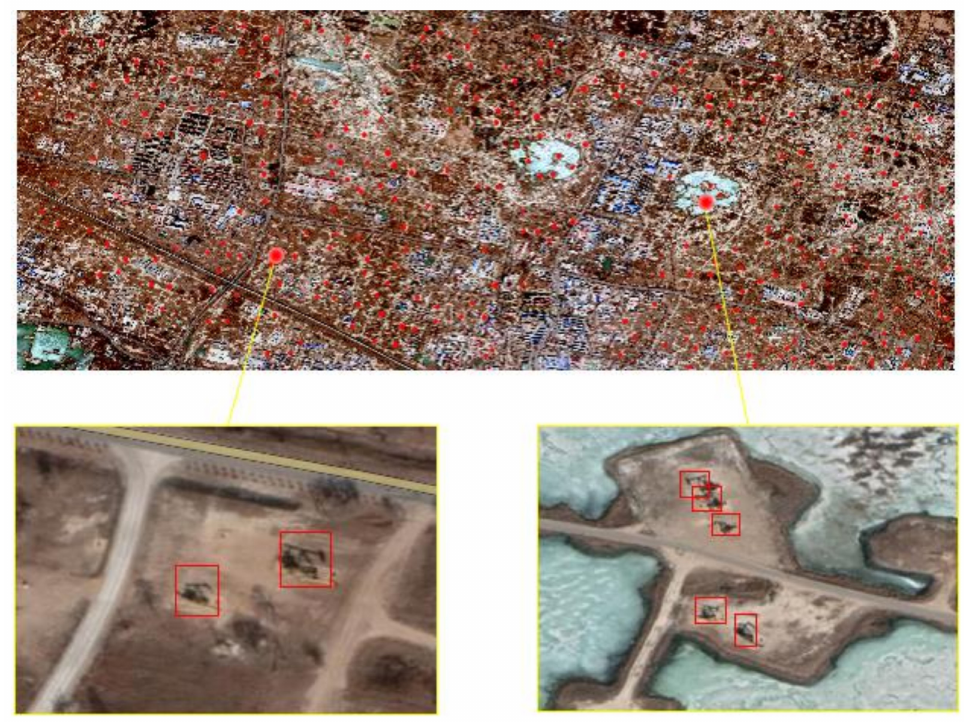
Figure 4. Map shows the image coverage of Northeast Petroleum University–Oil Well Object Detec- tion V1.0 (NEPU–OWOD) V1.0